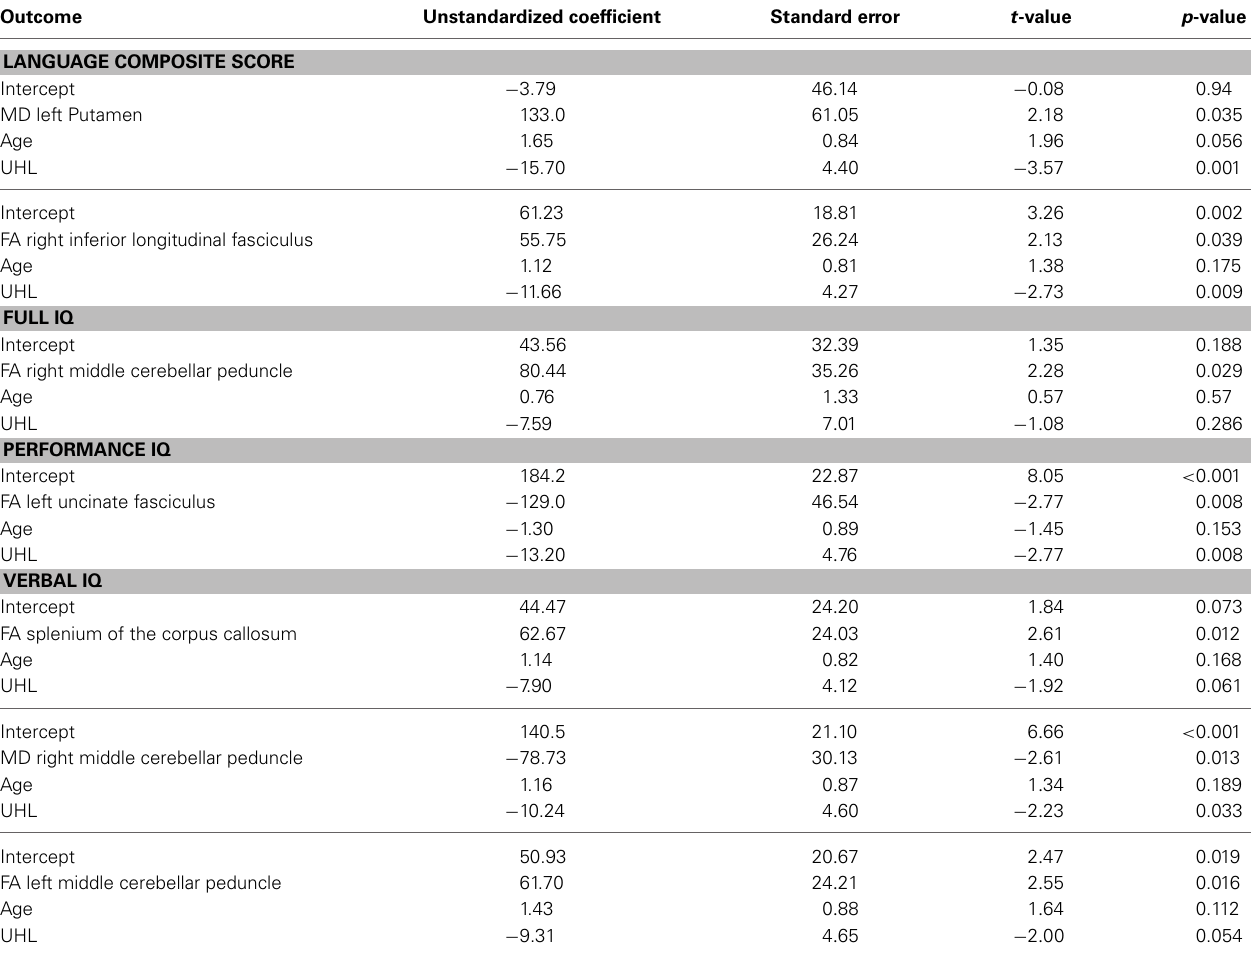
Table 7 | Results of multiple linear regression analyses for all subjects ( n = 49).